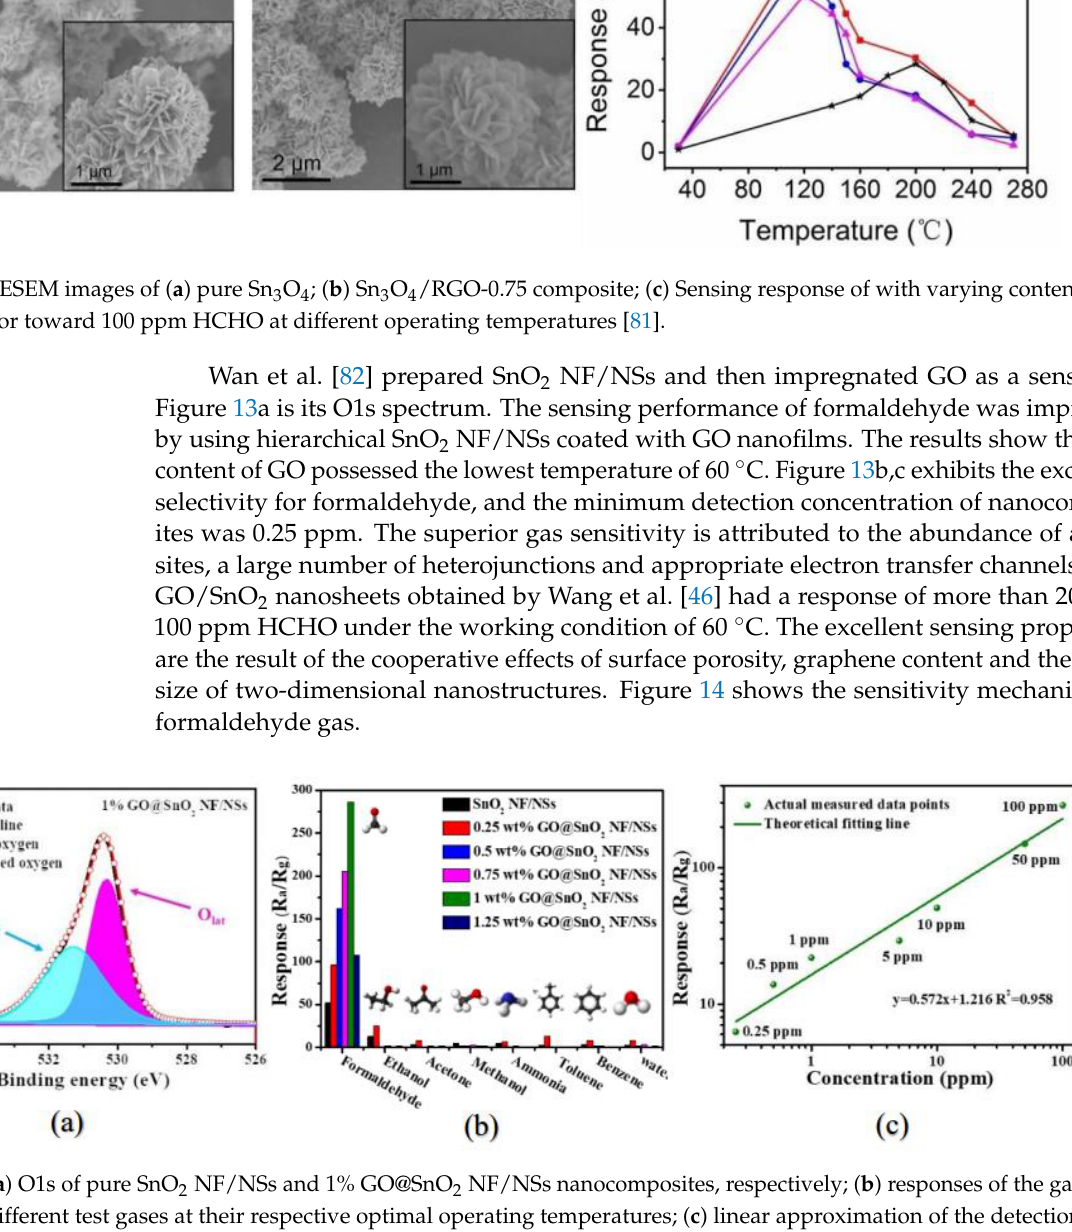
Figure 14. Schematic diagram of the sensing mechanism [46]. Fan et al. [30] assembled graphene nanosheets modified with ZnO nanoparticles con- taining dipoles by a simple solution process. ANS greatly promoted the charge transfer between material and formaldehyde molecules, which can be detected at a lower potential barrier. Manna et al. [60] calculated the adsorption properties of HCHO on graphene ox- ide (rGO) functionalized with Pt, Au and Ag. The quantum simulation results based on DFT show that the adsorption strength of different noble metal composite rGO to HCHO varies in the following the order: rGO-Pt n > rGO-Au n > rGO-Ag n .